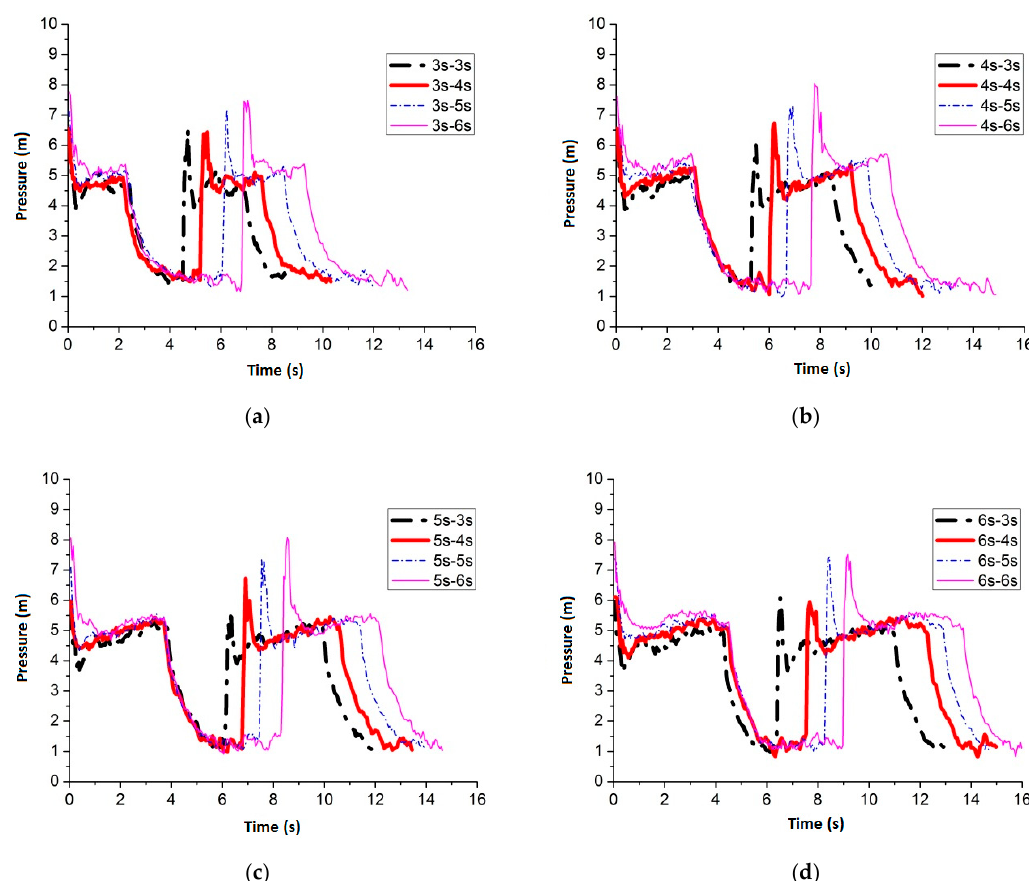
Figure 27. Pressure fluctuation of No. 1 sensing point when slot nozzle is set at the bottom of the pipe